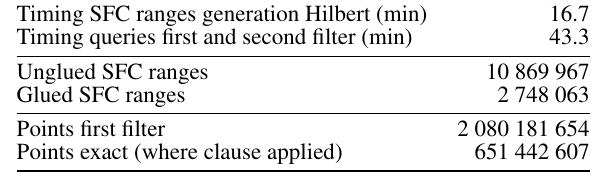
Table 4. Constructing the octree.